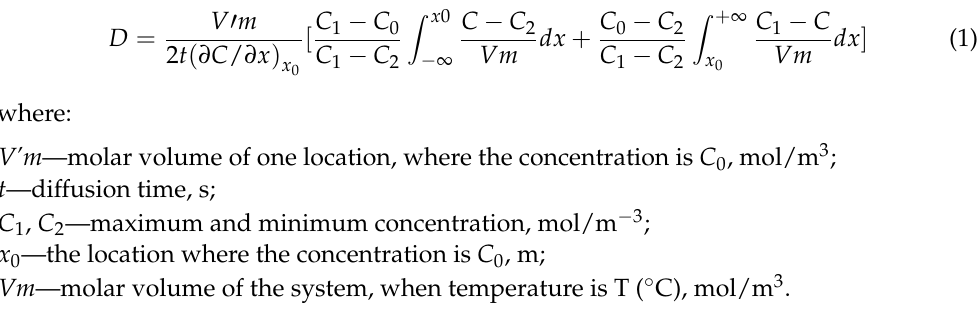
Figure 7. The results of glow discharge detection. ( a ) 1100 °C; ( b ) 1125 °C; ( c ) 1150 °C; ( d ) 1175 °C; and ( e ) 1200 °C.